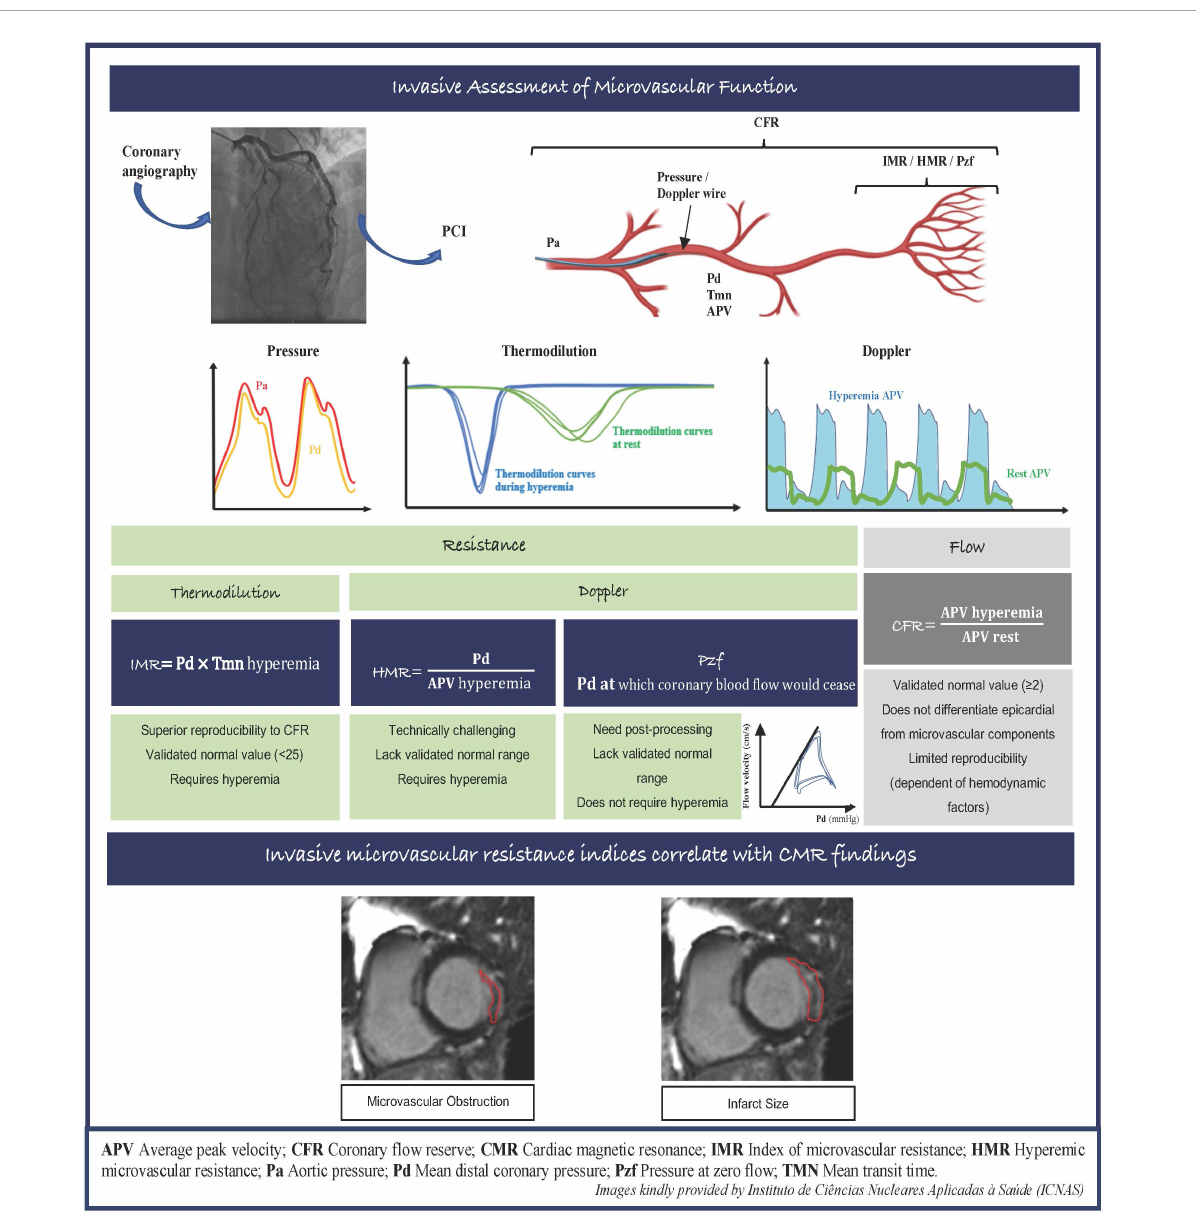
FIGURE1 Invasive assessment of microvascular function and correlation between invasive microvascular resistance indexes with CMR images in the MI setting. APV, average peak velocity; CFR, coronary flow reserve; CMR, cardiac magnetic resonance; IMR, index of microvascular resistance; HMR, hyperemic microvascular resistance; Pa, aortic pressure; Pd, mean distal coronary pressure; Pzf, pressure at zero flow; TMN, mean transit